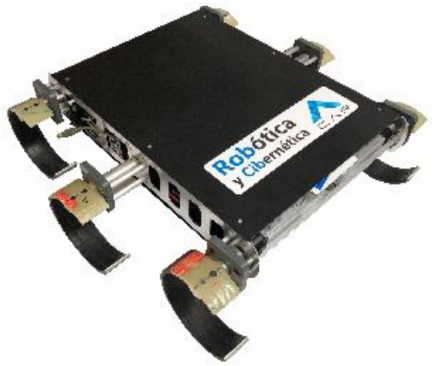
Figure 1. C-Legged hexapod robot designed and Manufactured by the Centro de Autom á tica